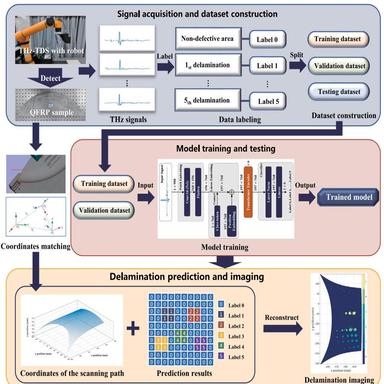
The framework of automatic delamination characterization using improved THz-TDS based on Transformer-based neural network.